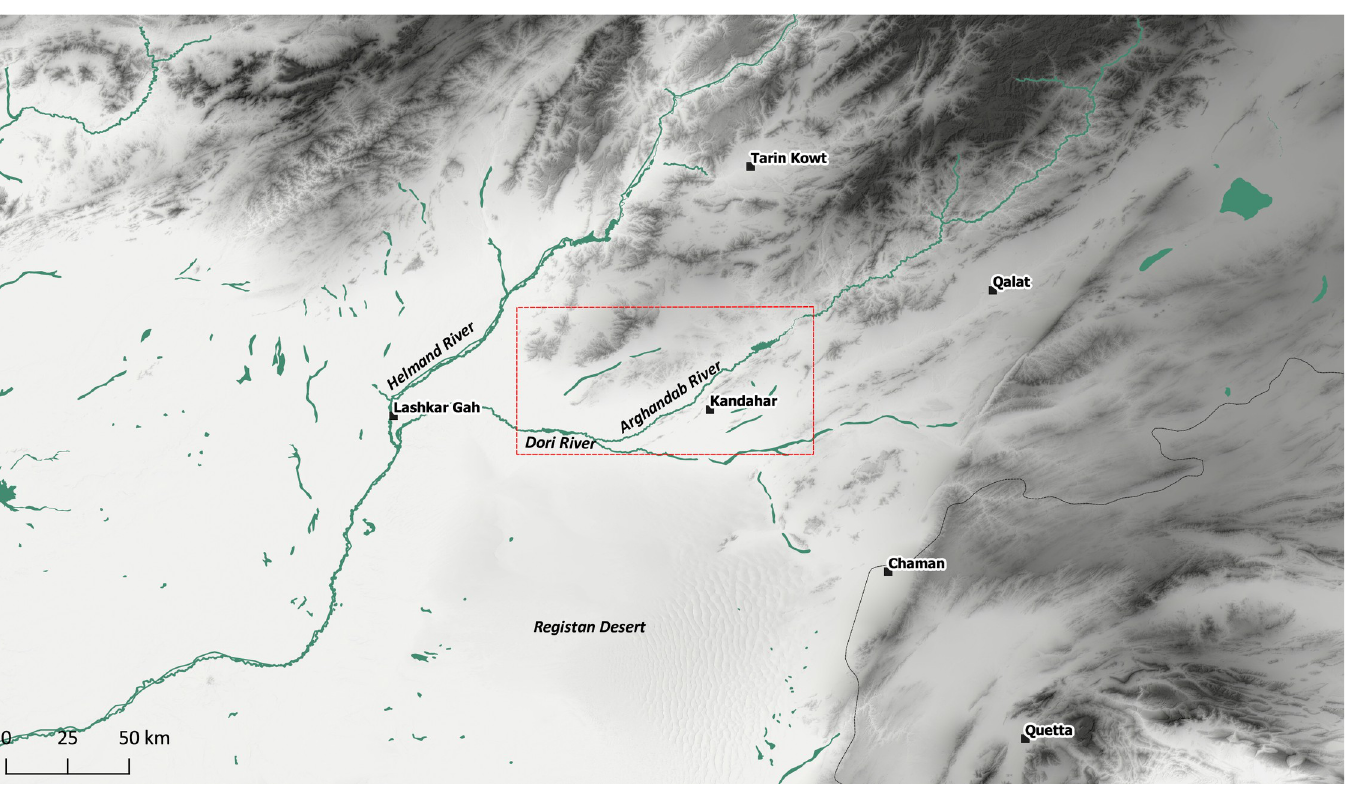
Fig 1. Map of the Kandahar region and Registan Desert. DEM based on Shuttle Radar Topography Mission (SRTM) 1 Arc-Second Global courtesy of the U.S. Geological Survey (doi:10.5066/F7PR7TFT) (https://earthexplorer.usgs.gov). The map was created by the authors in QGIS.